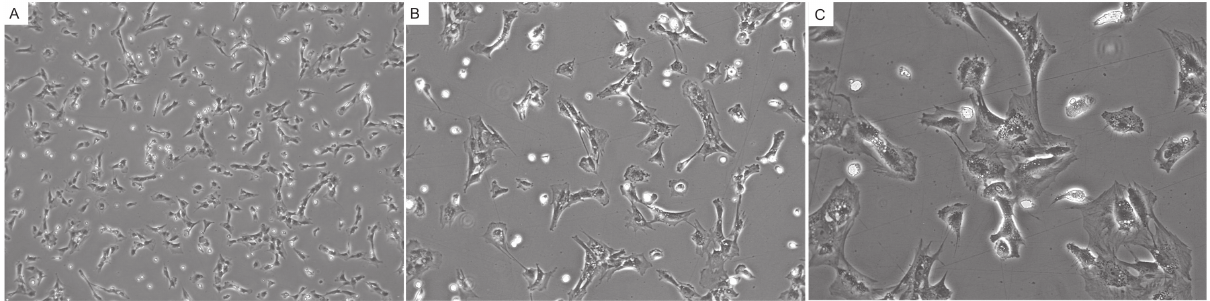
Figure 3- Morphology of MSCs-BM of Minipig BR-1: (A) 40x (B) 100x (C)